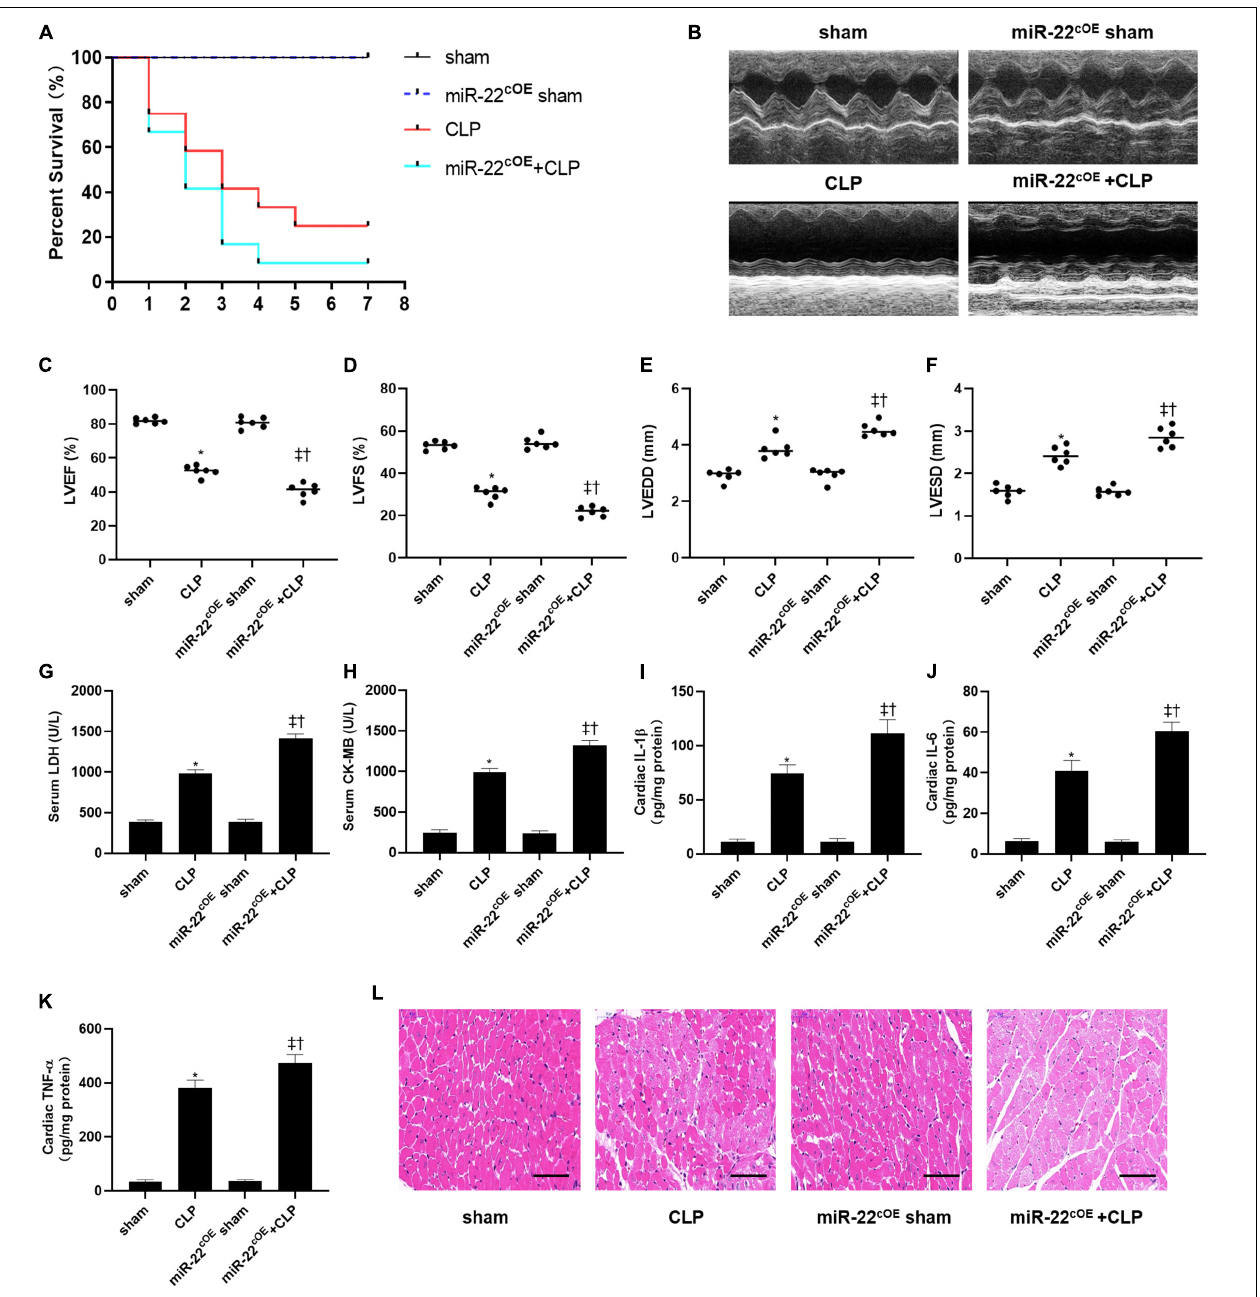
FIGURE 5 | Overexpressing miR-22 aggravates cardiac function and reduces the survival rate in CLP-induced cardiomyopathy. (A) Survival curves. Mortality was observed for 7 days, 12 mice of each group was used for comparison. (B) Representative images of M-mode Echocardiograms ( n = 6); (C) LVEF; (D) LVFS; (E) LVESD; (F) LVEDD; (G) serum LDH ( n = 6); (H) serum CK-MB ( n = 6); (I) cardiac IL-1 β ( n = 6); (J) cardiac IL-6 ( n = 6); (K) cardiac TNF α ( n = 6); (L) HE staining representative images. Scale bar = 25 µ m. Data were expressed as mean ± SEM. ∗ P < 0.05 vs. sham group; ‡ P < 0.05 vs. CLP group; † P < 0.05 vs. miR-22 cOE sham group. All the experiments were repeated three